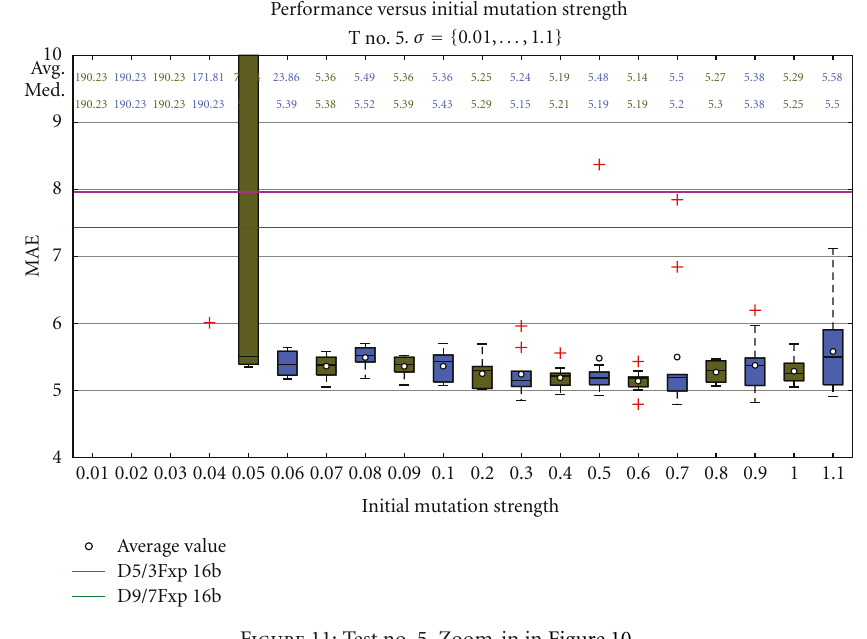
Figure 11: Test no. 5. Zoom-in in Figure 10.